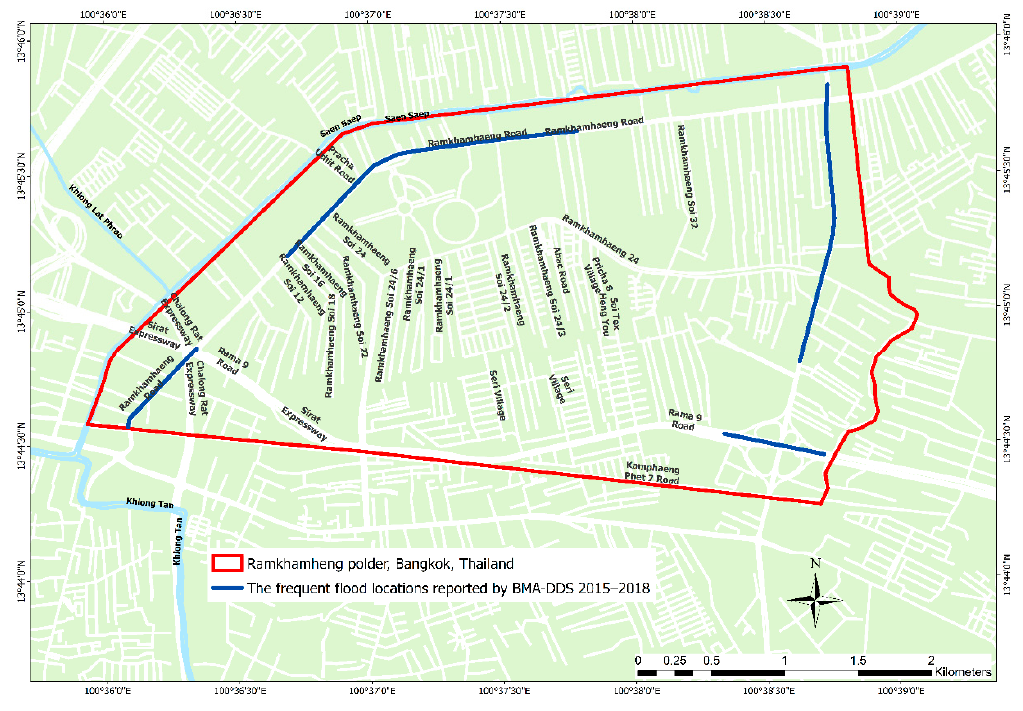
Figure 13. The three zones of frequent floods were reported by BMA-DDS [52]. Table 3. The comparison of the measured and simulated results in the three zones of Figure 12. Number of 2D Flooded Cells Zone Simulated